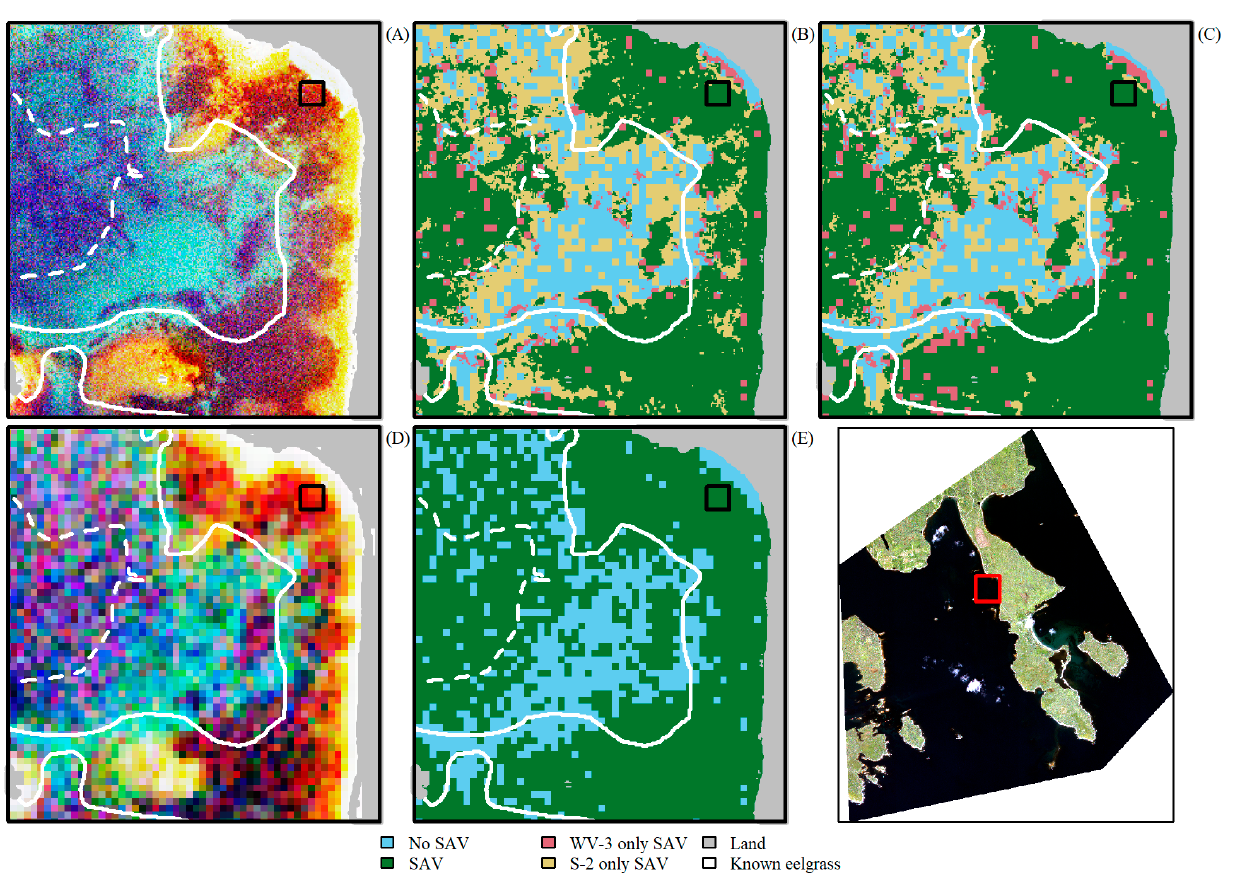
Figure 9. Comparison of bottom habitat maps produced by the full tile Sentinel-2 (13 September 2016) and WorldView-3 (17 August 2019). True colour composite of WorldView-3 ( A ) and Sentinel-2 ( D ) are given for reference. Bottom habitat classification using the same methods (B-G-R) for the WorldView-3 image ( B ) indicating the difference to Sentinel classification ( E ). Top performing bottom habitat classification for the WorldView-3 imagery ( C ) indicating the difference to Sentinel classification ( E ). Known locations of vegetated habitat (specifically eelgrass) are indicated by the black boxes. Solid white line corresponds to the 3 m depth contour, long dashed white line corresponds to the 7 m depth contour, short dashed line corresponds to the 10 m depth contour. Light grey corresponds to an image-based land mask.